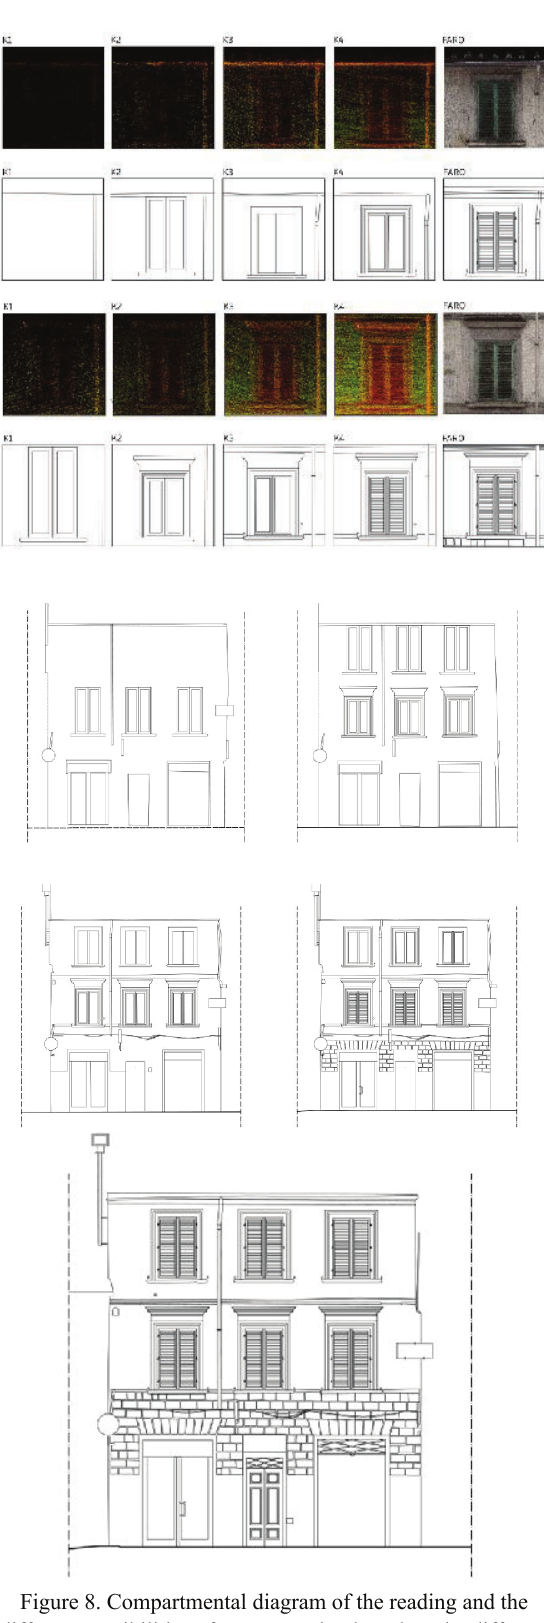
Figure 8. Compartmental diagram of the reading and the different possibilities of representation based on the different types of acquisitions made. Two windows were chosen on the front at the third and second level to evaluate the data. acquisition range; the same was then done for the entire portion of the urban